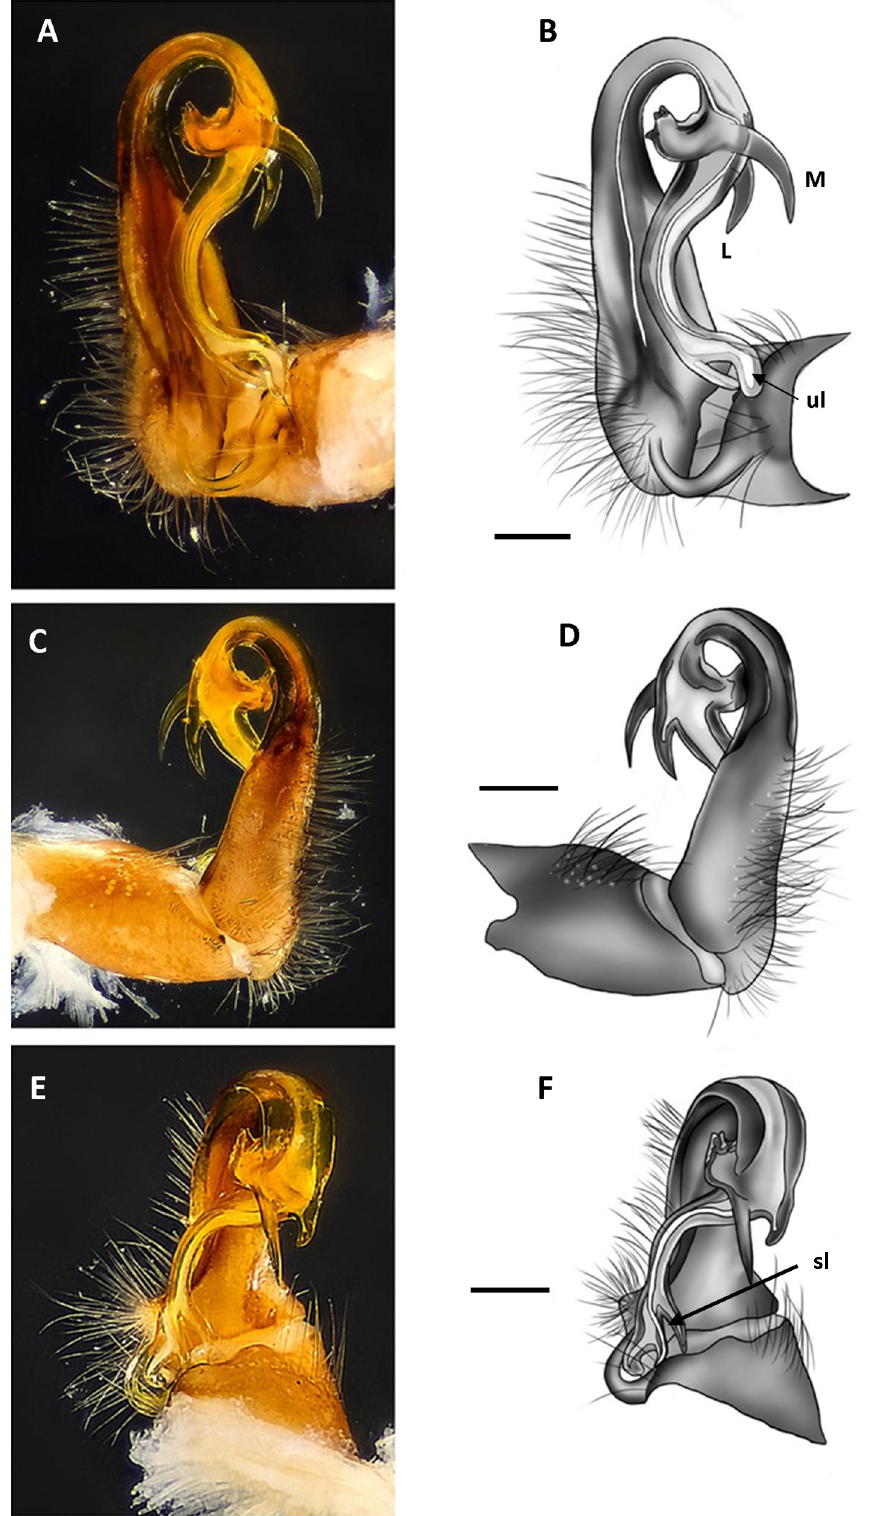
Fig. 11. Pogoro siren Rosenmejer & Enghoff sp. nov., holotype, ♂ (NHMD 621674), right gonopod. A–B . Mesal view. C–D . Lateral view. E–F . Dorsal view. Abbreviations: L = Process L; M = Process M; sl = subapical lobe; ul = uncate lobe. Scale bars: 0.5